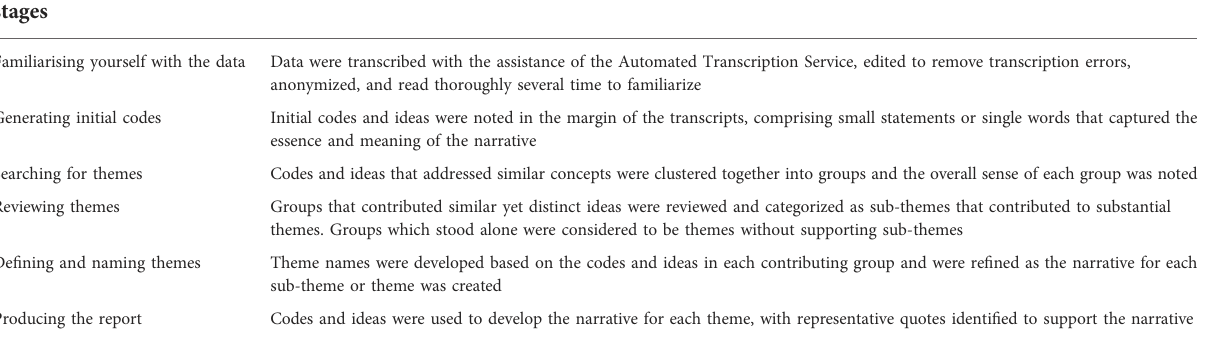
TABLE 1 Stages of thematic analysis [after Braun & Clarke (19, 20)] and their implementation during data analysis. Braun & Clarke suggested